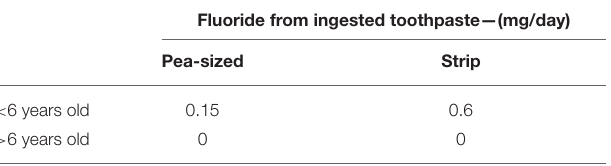
TABLE 3 | Amount of fluoride from toothpaste ingested by children based on age. Fluoride from ingested toothpaste—(mg/day)